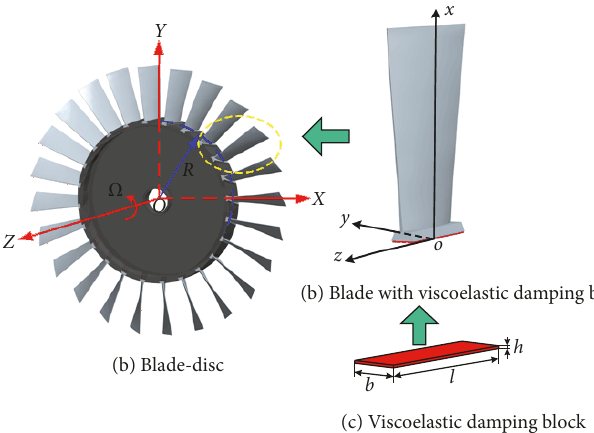
Figure 1: Schematic diagram of the blade-disc with viscoelastic damping